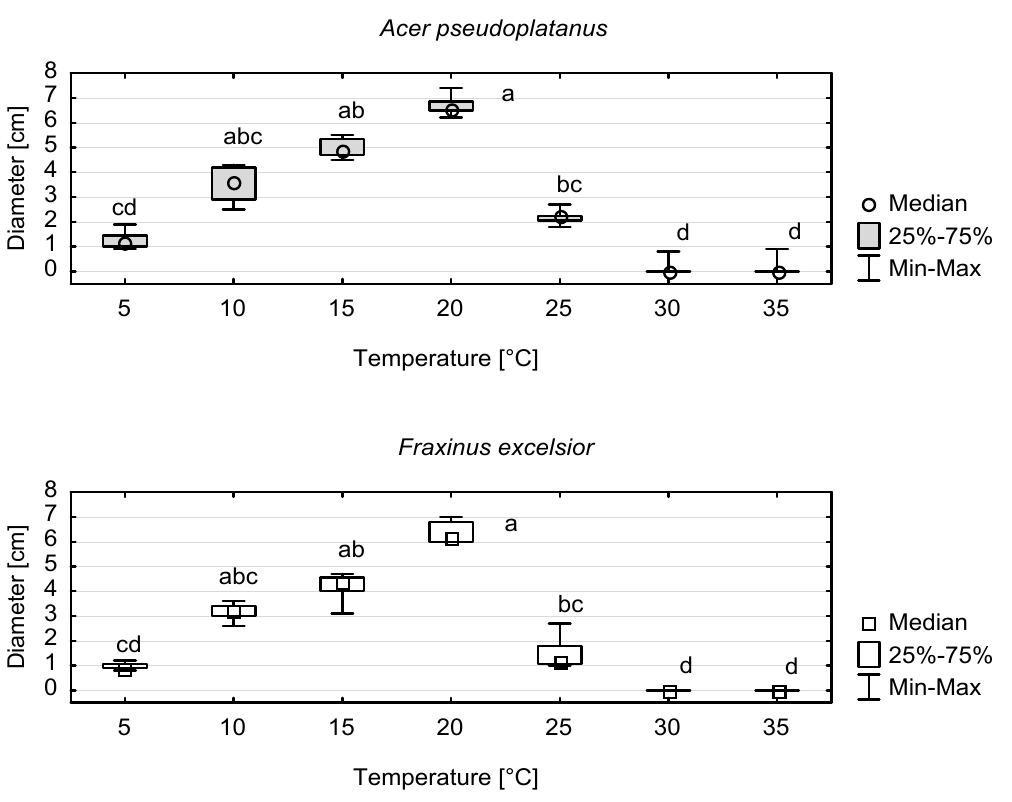
Figure 7. Diameters of Apiognomonia hystrix colonies isolated from Acer pseudoplatanus and Fraxinus excelsior after 10 days of growth at various temperatures. Values indicated with different letters have been determined significantly different at α = 0.05 in Kruskal–Wallis